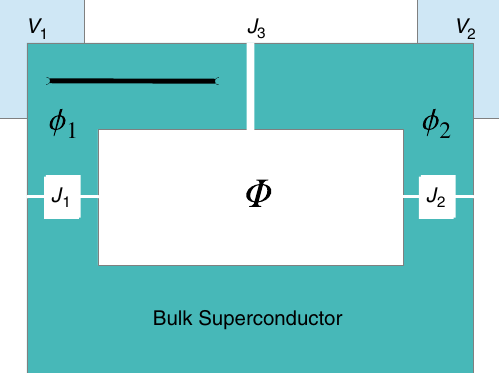
FIG. 3. Proposed device for implementing a phase gate. A Majorana nanowire sits on the upper left of two superconducting islands connected to a bulk superconductor. Josephson junctions J 1 and J 2 are adjustable, while a Josephson junction J 3 is strong and fixed. Gates of potential V 1 and V 2 are capacitively coupled to the superconducting islands. Operation of the phase gate is performed by ramping up the flux in the superconducting loop from Φ ¼ 0 to Φ ¼ 2 π , while the strengths of couplings J 1 and J 2 are comparable to draw a Josephson vortex into the loop through two interfering paths, then ramping the flux back down to zero with J 2 ≪ J 1 to release the vortex deterministically through the right